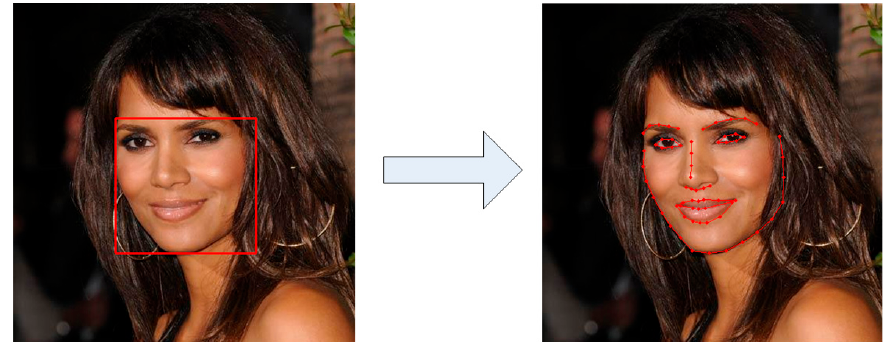
Figure 1. Face alignment example with the supervised descent method (SDM) algorithm [6]. Firstly, the face region is automatically detected in the image [11]. Then, features are localized within the detected face region. (Image courtesy of [12]).